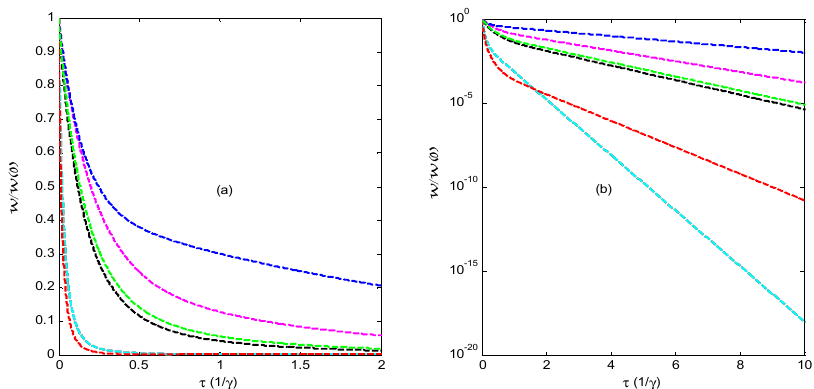
Figure 3. ( a ) waiting time distribuitions (WTDs) as a function of waiting time τ for different parameters. Δ = −7Γ (blue line); Δ = −4Γ (green line); Δ = 5.5Γ (red line); cavity without DQDs (black line); DQDs replaced by thermal bath 𝛾 (cid:3035) = 0.02, 𝑛(cid:3364) (cid:3035) = 10 (cyan), thermal bath 𝛾 (cid:3035) = 0.02, 𝑛(cid:3364) (cid:3035) = 0 (magenta); γ = 0.02 , 𝑛(cid:3364) = 1 , Γ = 1 , 𝜔 (cid:3040) = 10Γ , η = 0.05 , Ω (cid:2868) = 7𝛤 ; ( b ) the same curves as ( a ) on a logarithmic scale.